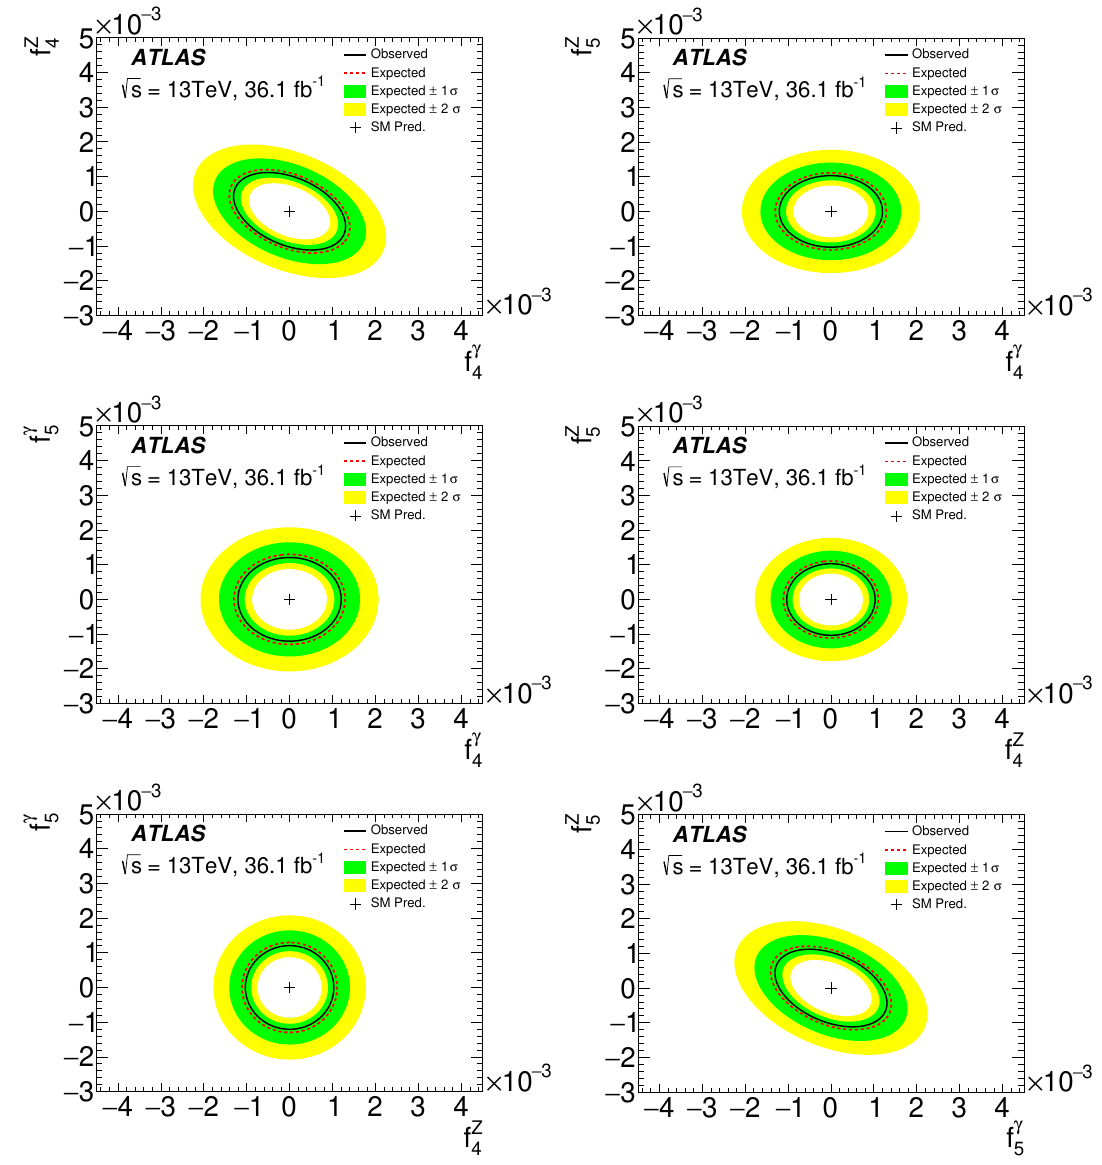
Figure 9 . Expected and observed regions excluded at 95% con(cid:12)dence level as a function of two aTGC parameters. Con(cid:12)dence intervals for each pair of coupling parameters are derived with the other two parameters set to